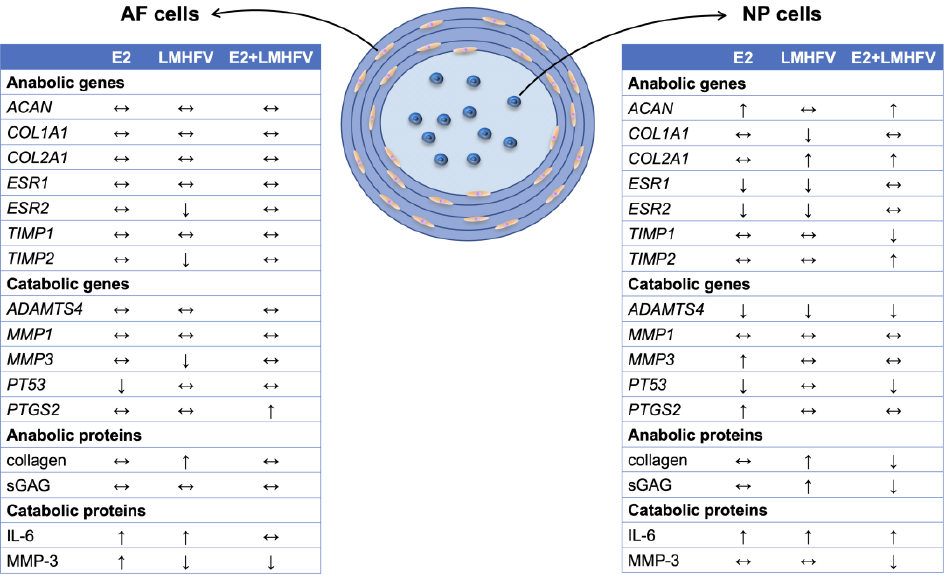
Figure 8. Regulation of anabolic and catabolic genes in AF and NP cells at day 8 of organ culture, and of proteins at day 21 by E2, LMHFV and E2 + LMHFV treatments compared to the unstimulated control group. ↑ , upregulation/increase; ↓, downregulation/decrease; ↔︎, no alteration.